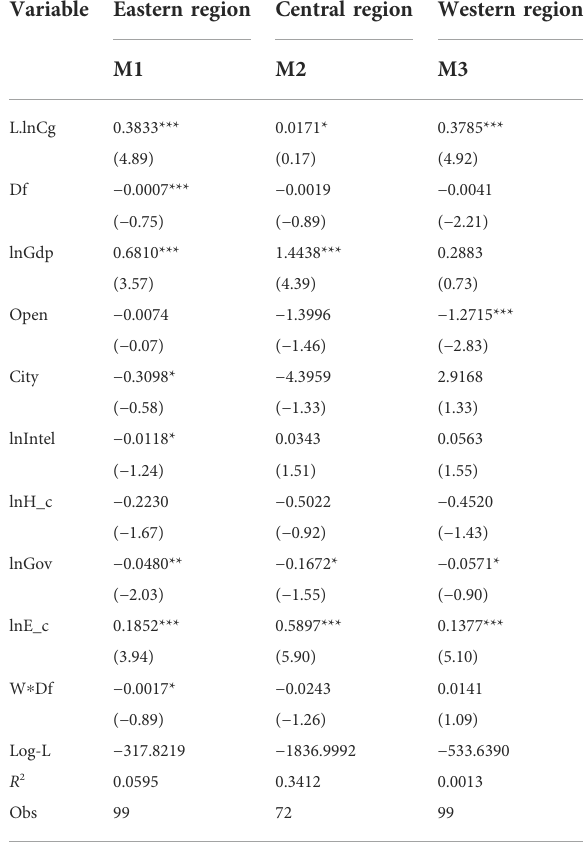
TABLE 4 Estimation results of the effect of digital fi nance on carbon emissions in regions with different development situations. Variable Eastern region Central region Western